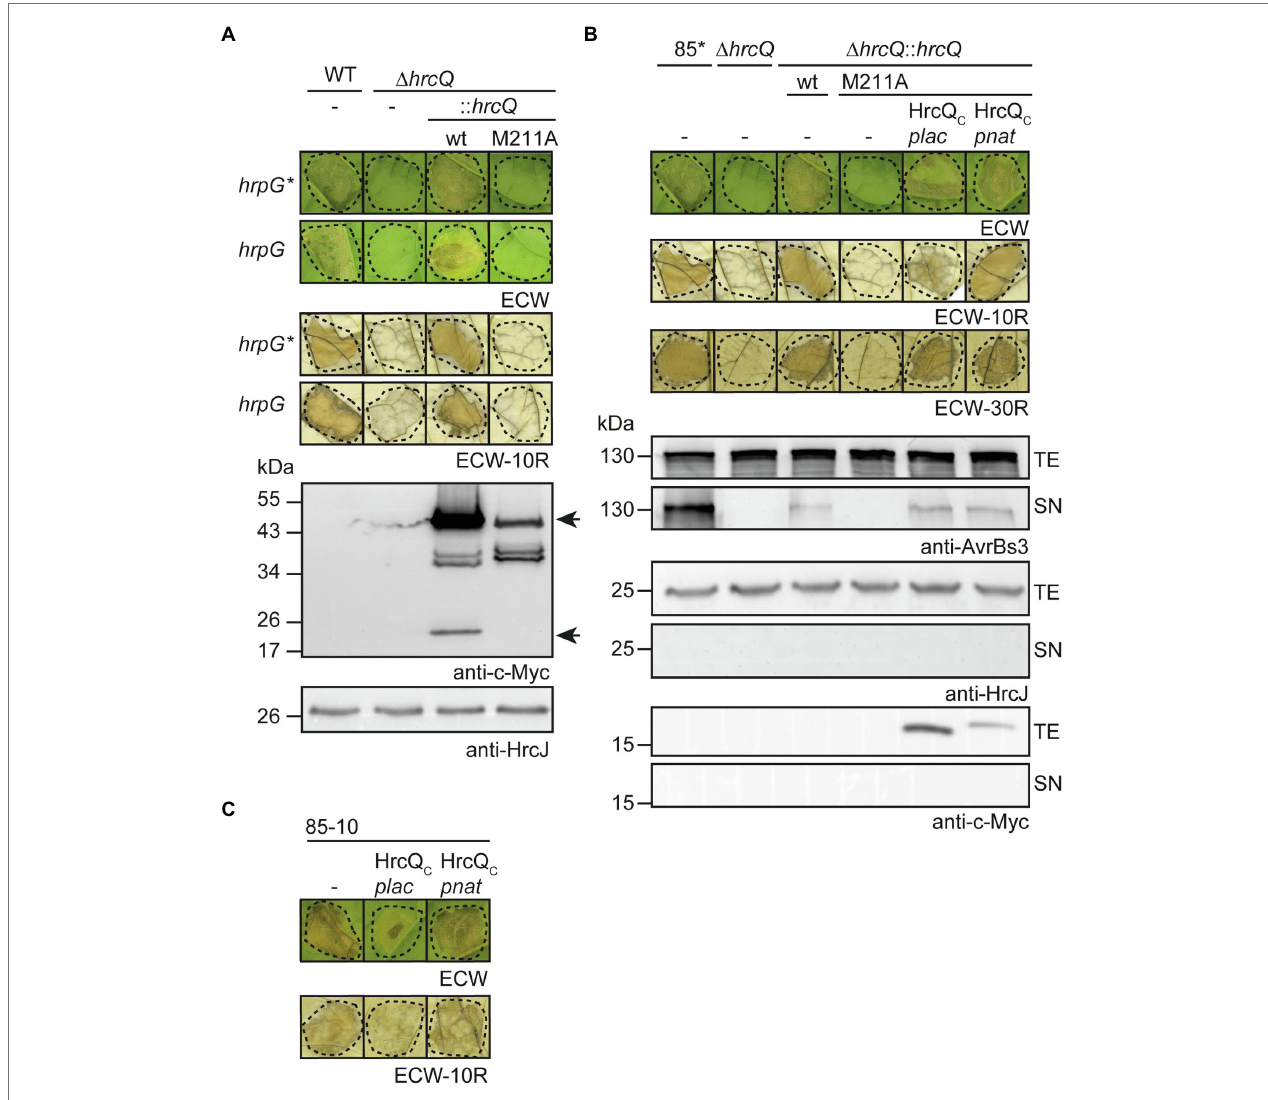
FIGURE 3 | Contribution of the internal translation start codon to pathogenicity of X. campestris pv. vesicatoria . (A) In cis expression of hrcQ M211A abolishes pathogenicity. Xanthomonas campestris pv. vesicatoria strains 85–10 (WT, hrpG ), 85* (WT, hrpG* ), and hrcQ deletion mutant derivatives thereof containing hrcQ-c- myc (wt) or hrcQ M211A -c-myc (M211A) inserted into the genomic hpaFG region under control of the native promoter were infiltrated into leaves of susceptible ECW and resistant ECW-10R pepper plants. Disease symptoms were photographed 8 dpi. For the better visualization of the HR, leaves were bleached in ethanol 2 dpi. Dashed lines indicate the infiltrated areas. For protein analysis, bacteria were grown in minimal medium and equal amounts of cell extracts were analyzed by immunoblotting using a c-Myc epitope-specific antibody. The blot shows the extracts of hrpG* strains and was reprobed with an antibody specific for the inner membrane (IM) ring protein HrcJ to demonstrate equal loading. Arrows indicate signals corresponding to the size of HrcQ-c-Myc and the predicted internal translation product HrcQ C -c-Myc. (B) In trans expression of HrcQ C restores pathogenicity of genomic hrcQ M211A mutants and in vitro type III secretion (T3S). Strains 85* and 85* ∆ hrcQ ( ∆ hrcQ ) with or without genomic insertion of hrcQ-c-myc (wt) or hrcQ M211A -c-myc (M211A) and containing either no plasmid ( − ) or expression constructs encoding HrcQ C -c-Myc under control of the native ( pnat ) or the lac ( plac ) promoter as indicated were infiltrated into leaves of susceptible ECW, AvrBs1- responsive ECW-10R, and AvrBs3-responsive ECW-30R pepper plants. Dashed lines indicate the infiltrated areas. Disease symptoms were photographed 8 dpi. For the better visualization of the HR, leaves were bleached in ethanol 2 dpi. For in vitro T3S assays, bacteria were incubated in secretion medium, and equal amounts of total cell extracts (TE) and culture supernatants (SN) were analyzed by immunoblotting using antibodies specific for AvrBs3, the IM ring component HrcJ and the c-Myc epitope. For the analysis of in vitro T3S of AvrBs3, X. campestris pv. vesicatoria strains contained an expression construct encoding AvrBs3 under control of the lac promoter. (C) Ectopic expression of hrcQ C under control of the lac promoter exerts a negative effect on pathogenicity. Strain 85–10 without plasmid ( − ) or containing expression constructs encoding HrcQ C under control of the lac ( plac ) or the native ( pnat ) promoter as indicated was infiltrated into leaves of susceptible and resistant plants and plant reactions were documented as described in (A) . Experiments in (A–C) were performed three times with similar